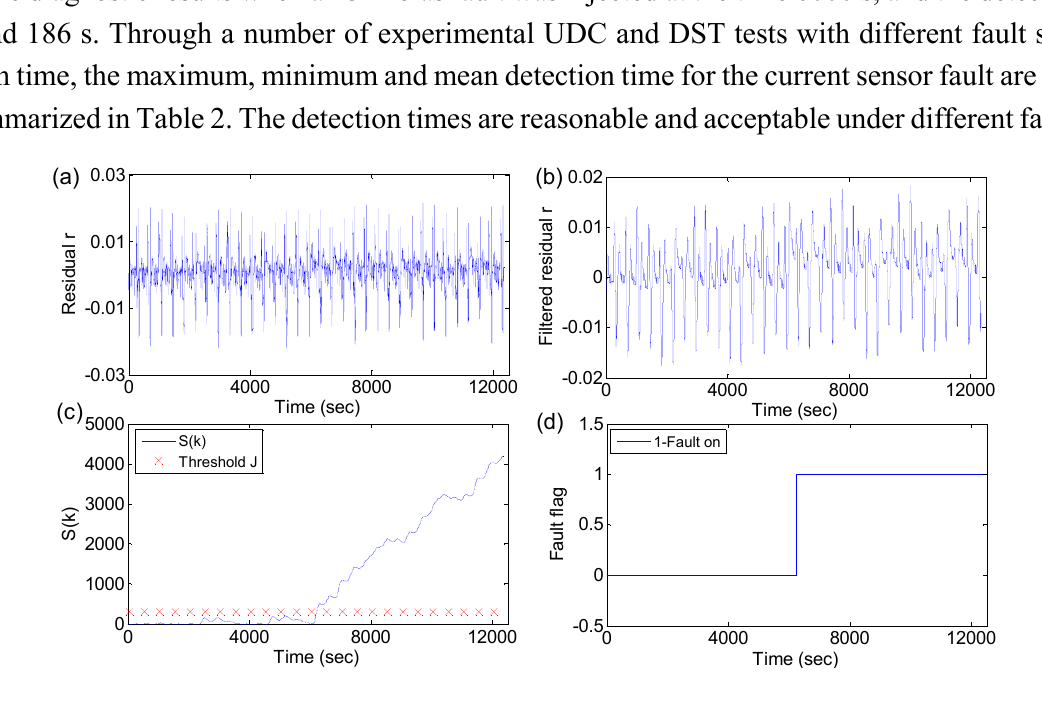
Figure 11. Current sensor fault diagnostic results under DST test. ( a ) Generated residual r ; ( b ) Filtered residual r ; ( c ) Residual evaluation result S ( k ) using CUSUM; ( d ) Detected current sensor